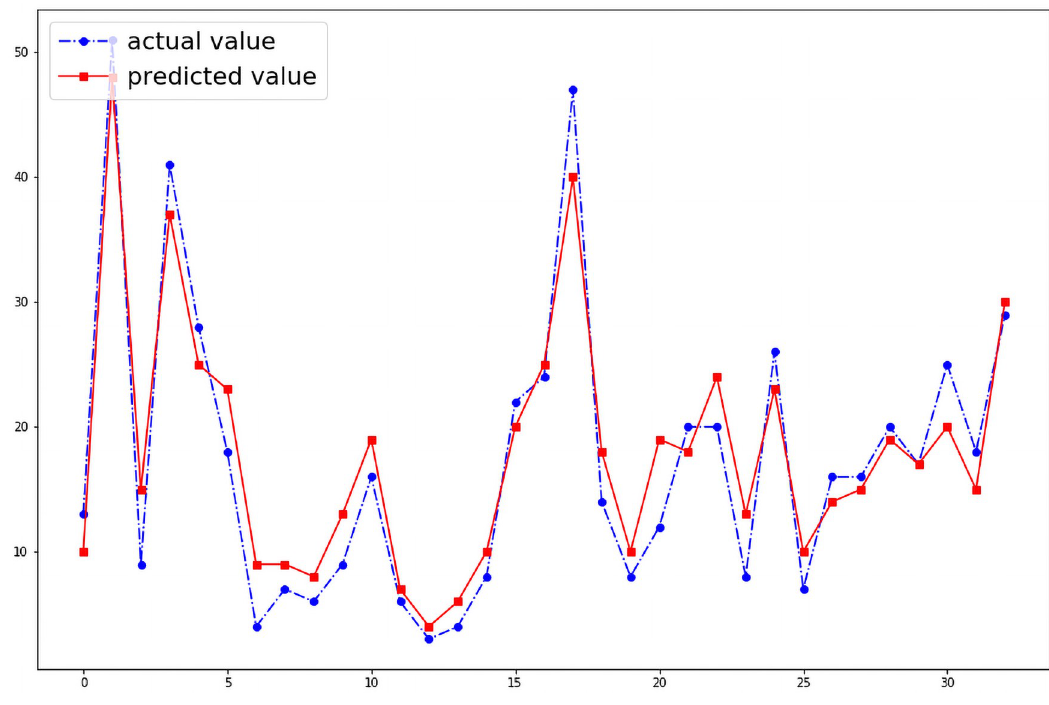
Fig 8. Final model (RMSE: 10.84).